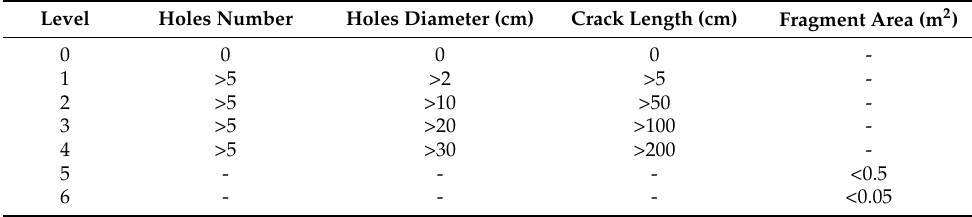
(Table 1). The degradation degree was divided into Level 0 to Level 6 and defined as follows: Table 1. Quantitative degradation grading observation